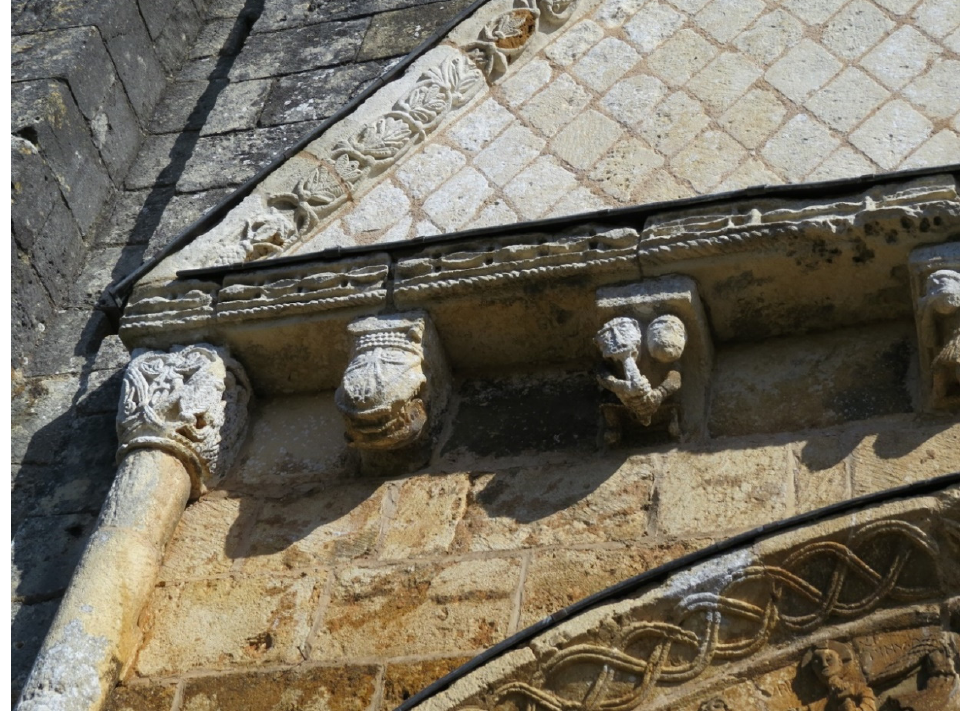
Figure 16. Corbels, detail, west façade, Saint-Martin Church , 12th c., Besse, Dordogne, Nouvelle-Aquitaine, France. ©Author.